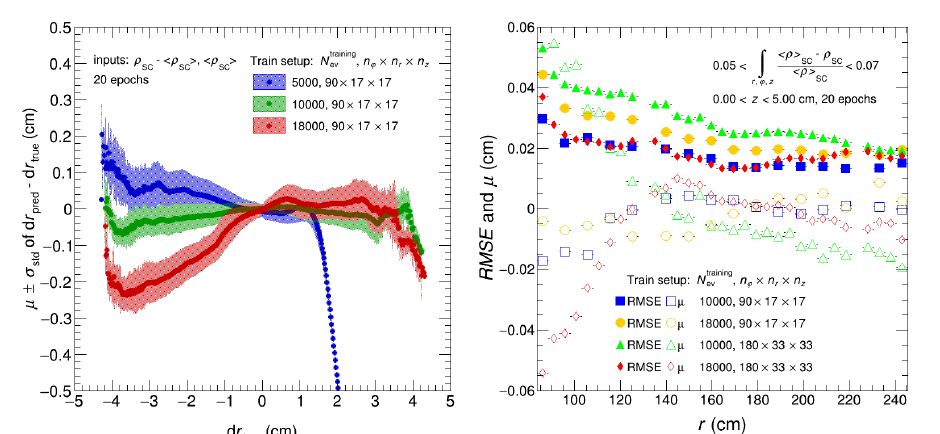
Figure 4. Left: The mean µ (data points) and the standard deviation σ std (error bands) of the dif- ference between the predicted and the expected distortion fluctuations d r pred d r true as a function − of the true distortion fluctuations d r true . The data show the results of models with a granularity of n ϕ n r n z = 90 17 17. The di ff erent colors represent models trained by di ff erent numbers of × × × × events. Right: The mean value and the root mean squared error RMSE of the di ff erence between the predicted and the expected distortion fluctuations d r pred d r true as a function of the radius r . It is shown − for 0 < z < 5cm and it is averaged over ϕ . A small interval of the integrated relative space-charge ρ ρ / ρ σ of the distribution is selected. The di ff erent density fluctuations ( SC (cid:28) − SC ) SC (cid:28) at around 1 r ,ϕ, z (cid:29) (cid:29) colors show data for di ff erent grid sizes and N training ev (cid:31)